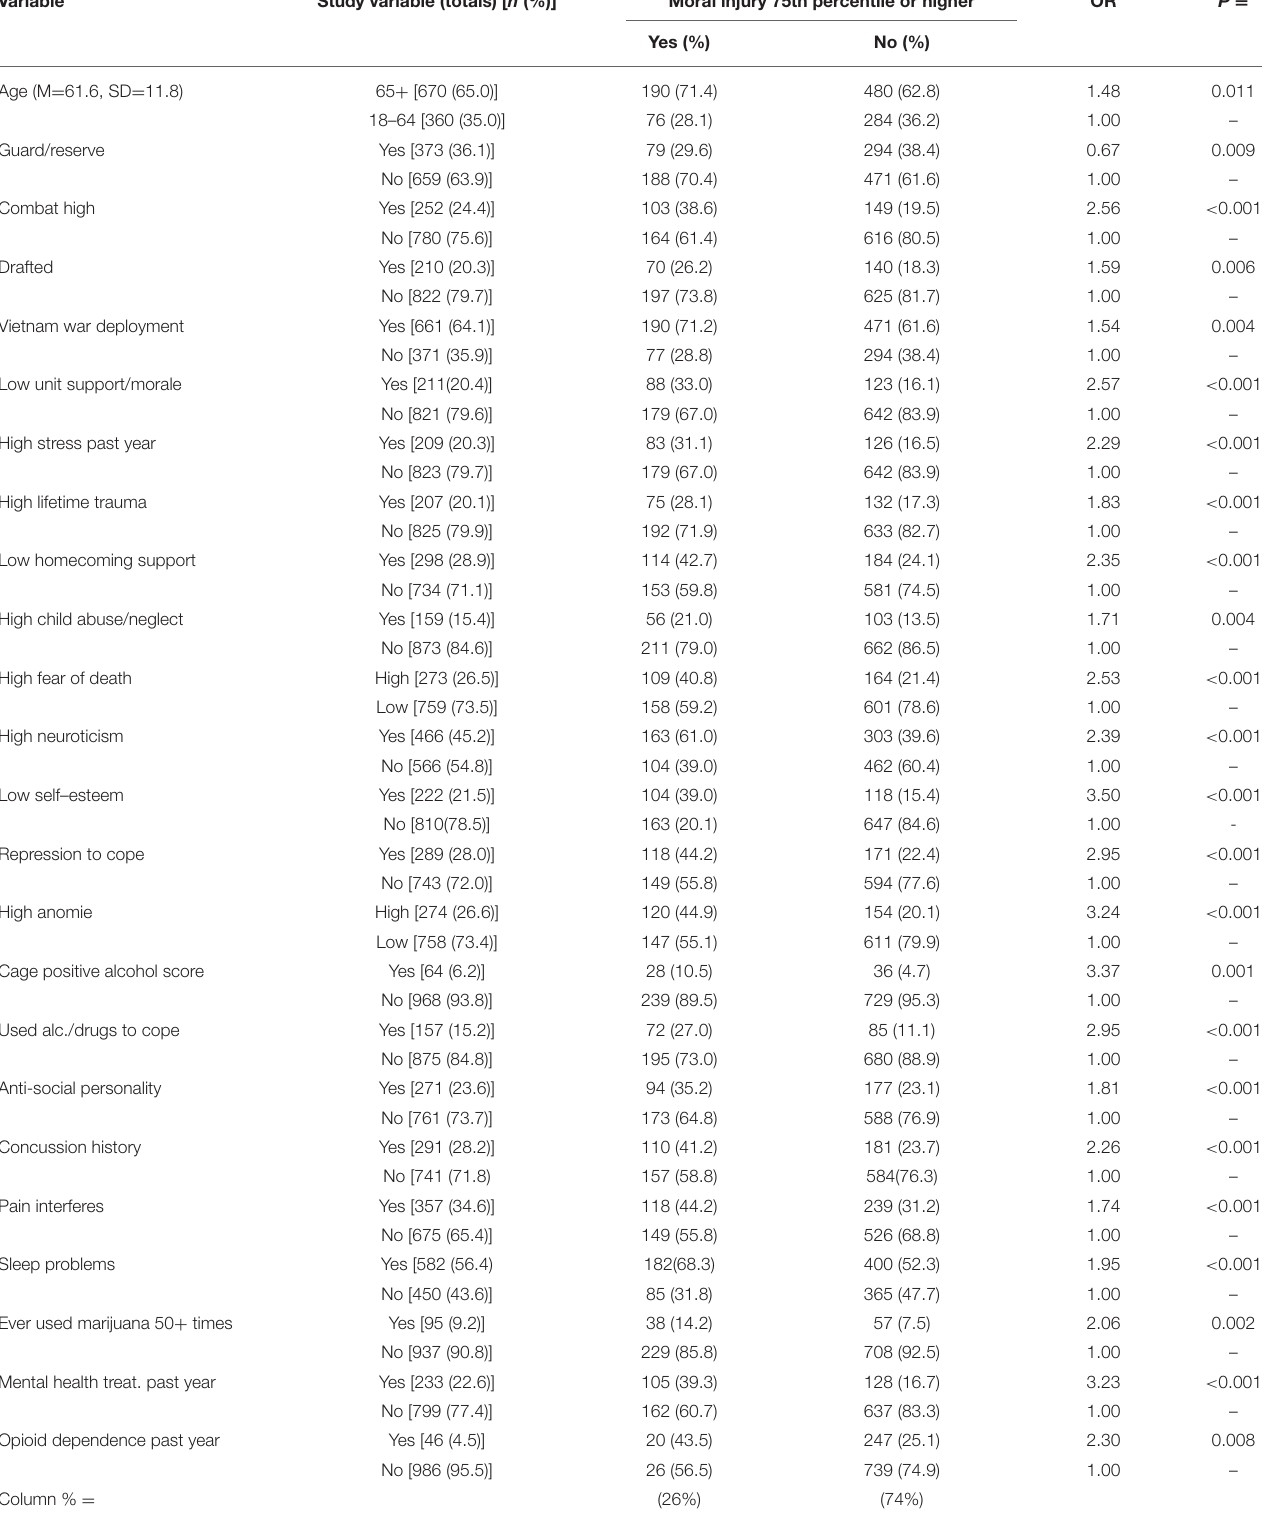
TABLE 1 | High moral injury score vs. low score by study independent/control variables, based on Col. % ( N = 1,032). Variable Study variable (totals) [ n (%)]